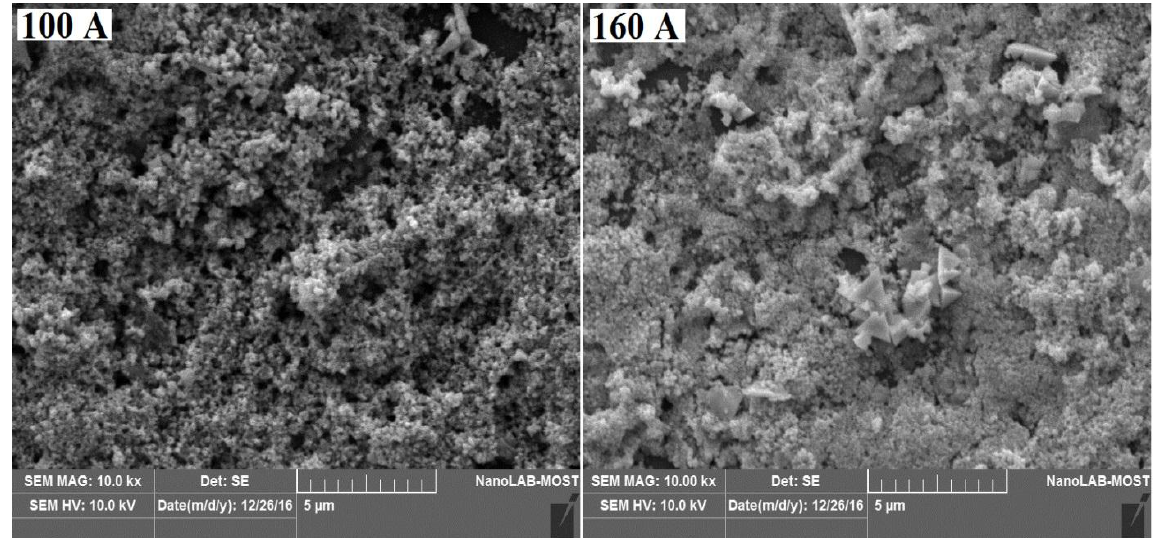
Fig. 4: SEM images for producer using exploding Cu wire in Iodine solution using 100 and 160 A current.